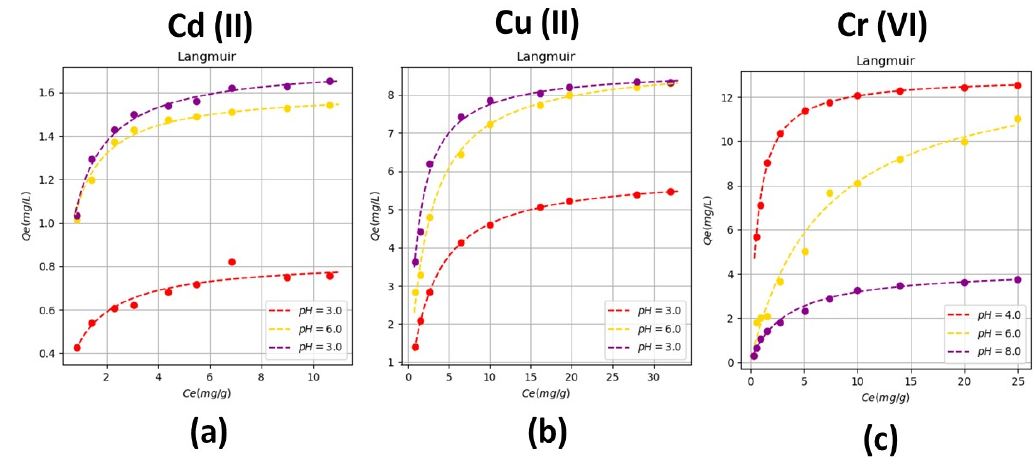
Figure 5. Isotherm of Langmuir at different pH values ( a ) Cd (II), ( b ) Cu (II) and ( c ) Cr (VI) at 298.15 K.